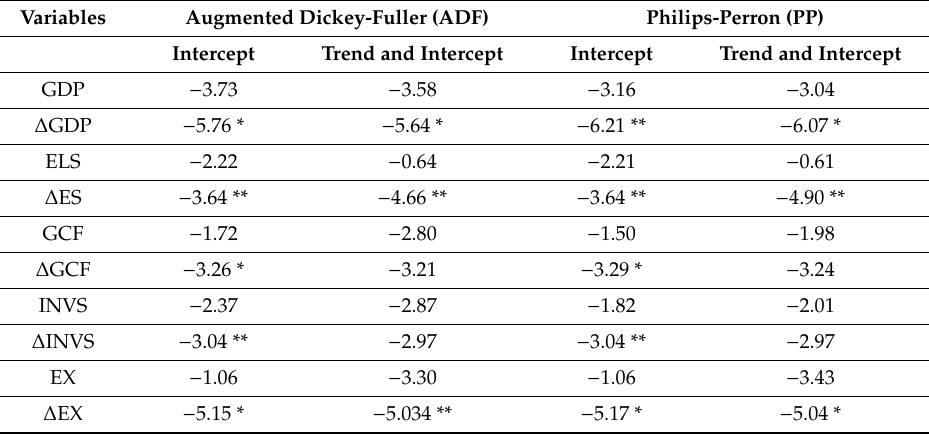
Table 4. Unit root test outcomes of total variables.